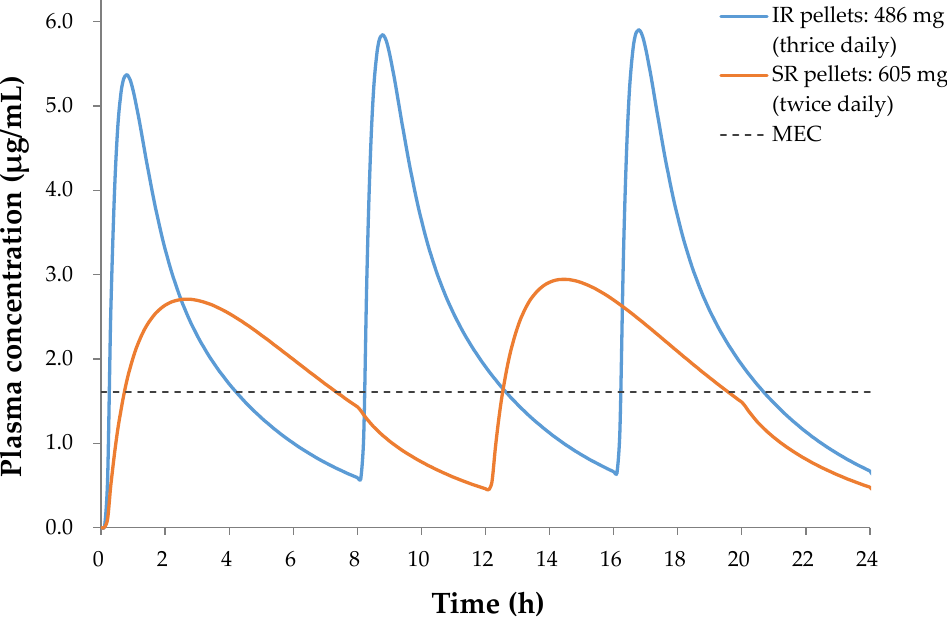
Figure 8. Comparison of pharmacokinetic profiles for the IR pellets (4.99 h − 1 of k d ) and the SR pellets (0.65 h − 1 of k d ), indicating that the SR pellets is advantageous from the perspectives of both compliance and efficacy improvement.